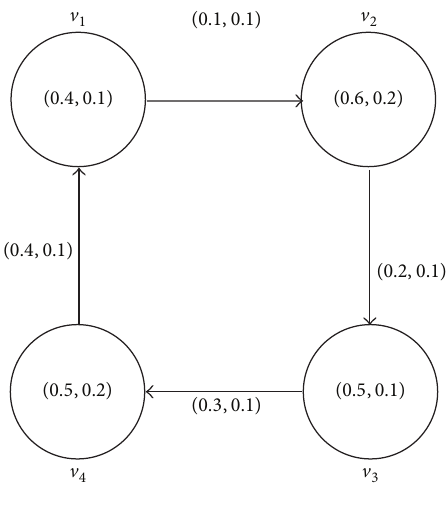
Figure 1: Intuitionistic fuzzy digraph.